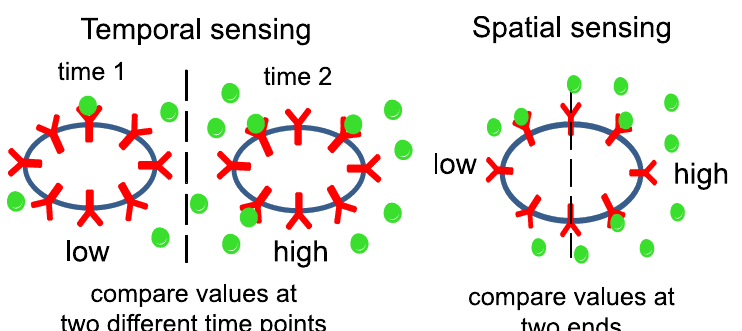
Fig 1. Schematic of temporal and spatial sensing. For temporal sensing, the cell compares the output at two different time points (left). For spatial sensing, the cell compares the ouput at its two ends